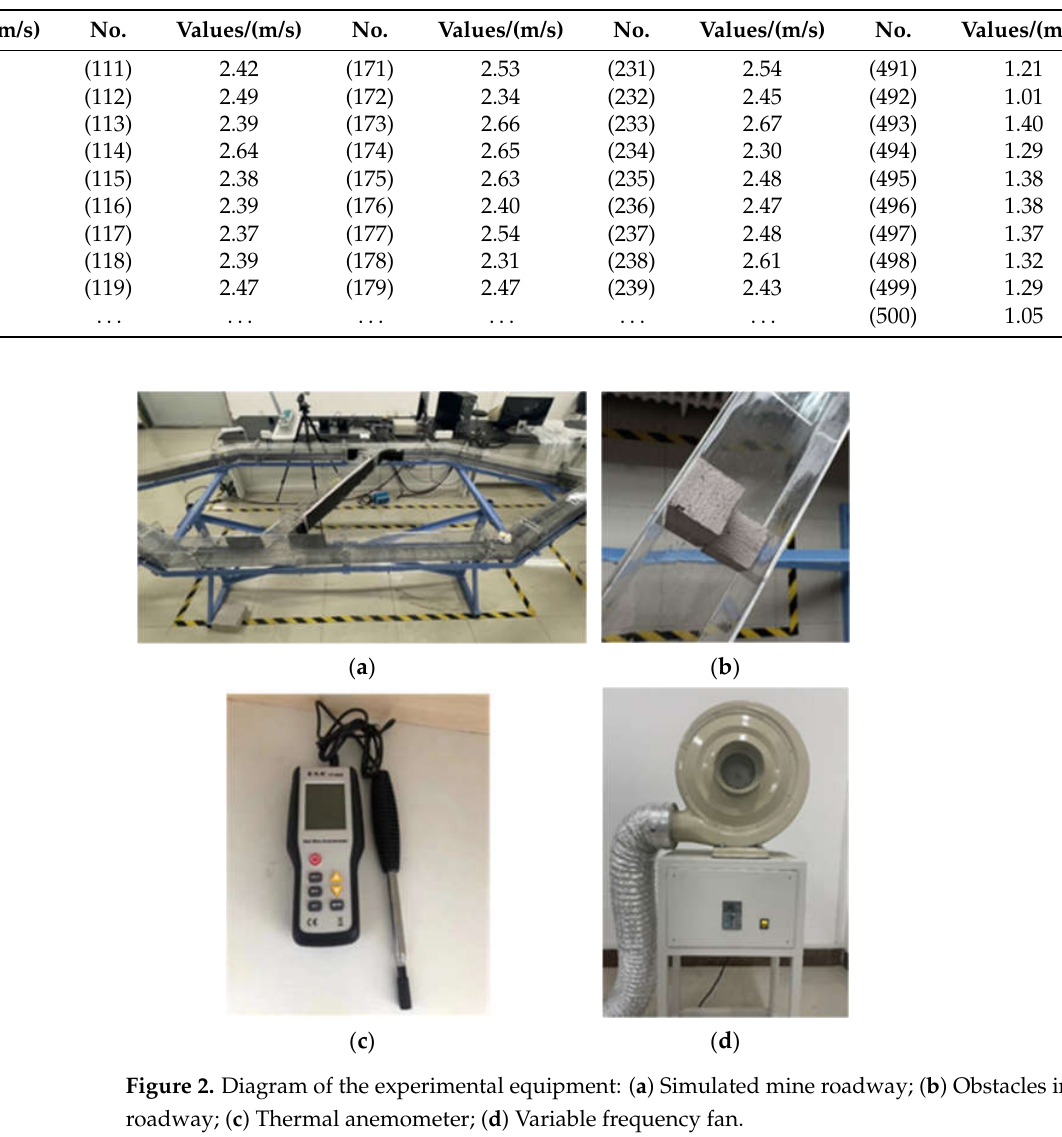
Table 1. Monitoring wind speed sensor data in a certain period in coal mines.